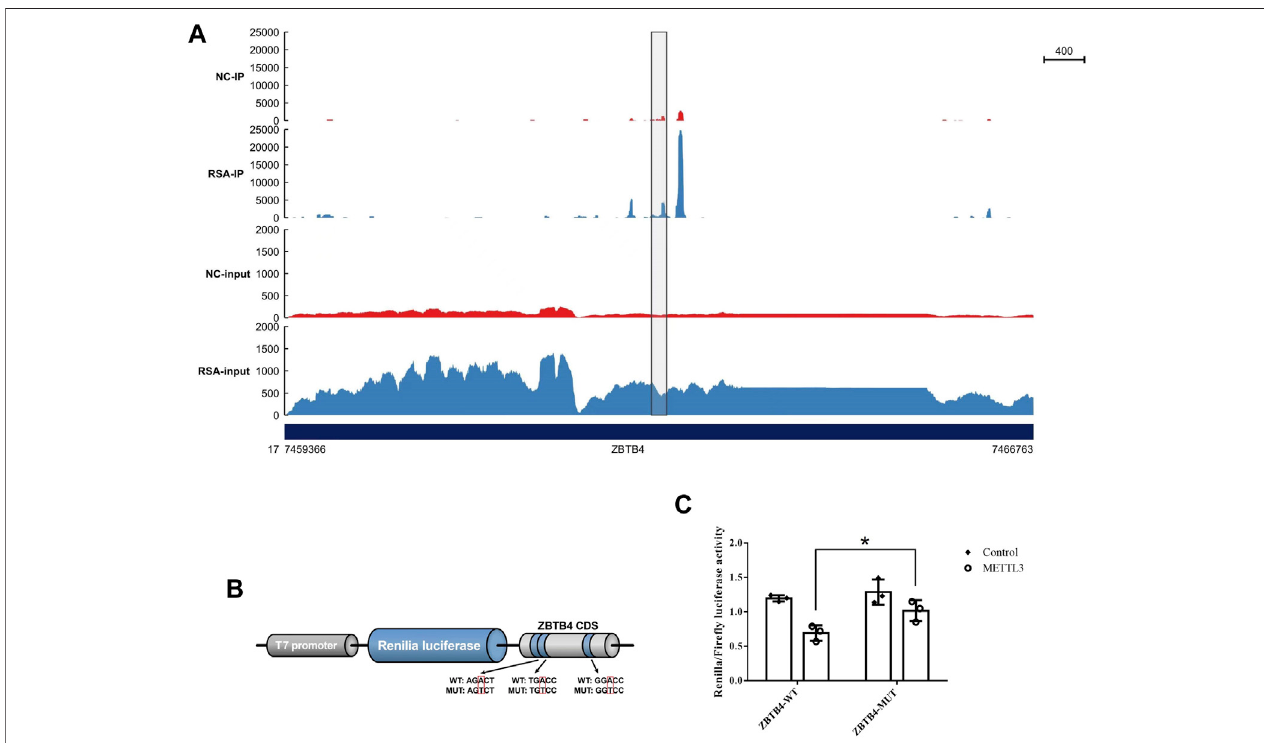
FIGURE4| METTL3mediatedm 6 Amodi fi cationofm6AmotifsinZBTB4CDS. (A) m 6 ApeaksinZBTB4mRNAtranscriptsinRSAandcontrolsamplesasdetected by MeRIP-seq. The m 6 A peaks with a signi fi cant increased or reduced abundance (fold change > 2, p < 0.05) are shown in the grey frame. (B) Wild-type and mutant fragmentsofZBTB4CDSwereclonedintothedownstreamoftheRenillaluciferasegeneofpsiCheck2vector. (C) Renillaluciferaseactivitywasdetectedandnormalized to that of the fi re fl y luciferase. Three independent experiments were